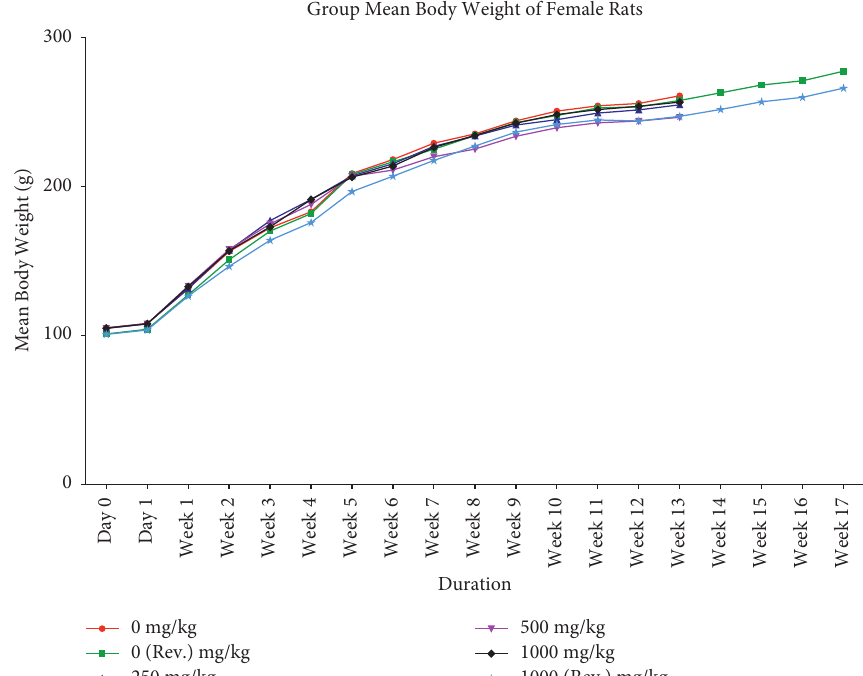
Figure 2: Group mean body weight (mean ± SD) of female rats orally administered with GutGard for 90 days ( n � 10; n � 5 for reversal groups; p ≤ 0 . 05).